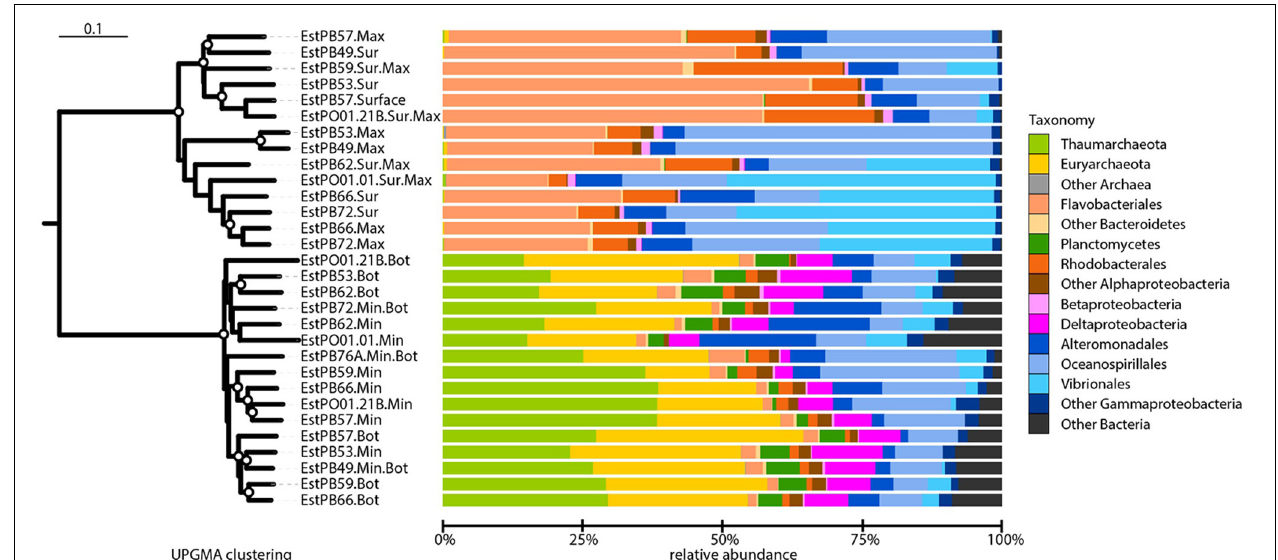
FIGURE 4 | Beta-diversity analysis and taxonomic composition of Southern Ocean samples collected from near the seafloor (Bot), at the minimum or maximum oxygen depth (Min or Max, respectively), or at the surface (Sur). Samples IDs are as shown in Table 2 . Left : unweighted pair group method with arithmetic mean (UPGMA) dendrogram based on